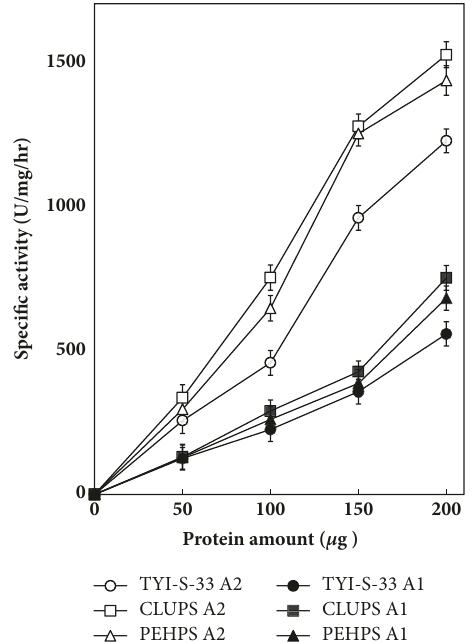
Figure 3: Phospholipase A1 (A1) and phospholipase A2 (A2) activity of P30 trophozoite fractions according to protein amount. E. histolytica trophozoites were grown in PEHPS, TYI-S-33, or CLUPS; mean ± SD of quintuplicated